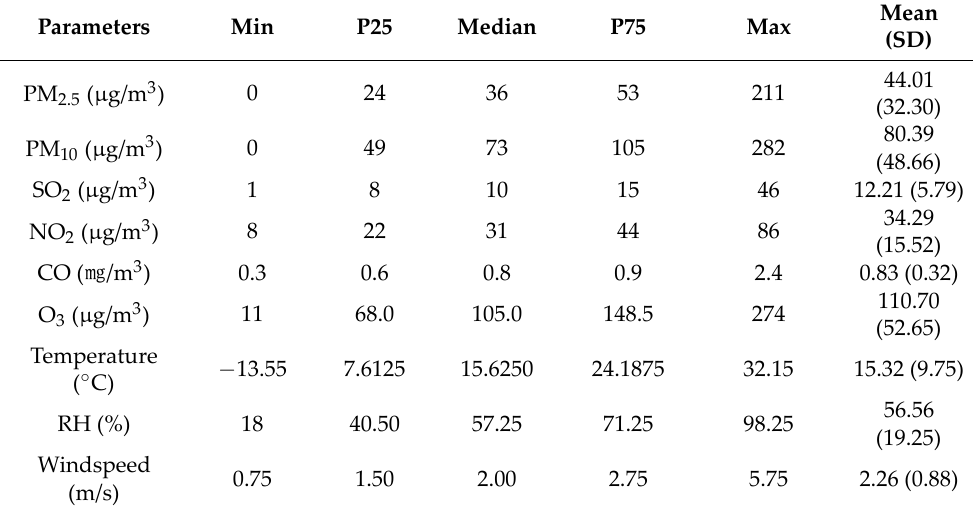
Table 2. Descriptive statistics of air pollutants and meteorological factors in Jinan, China, from 2020 to 2021.